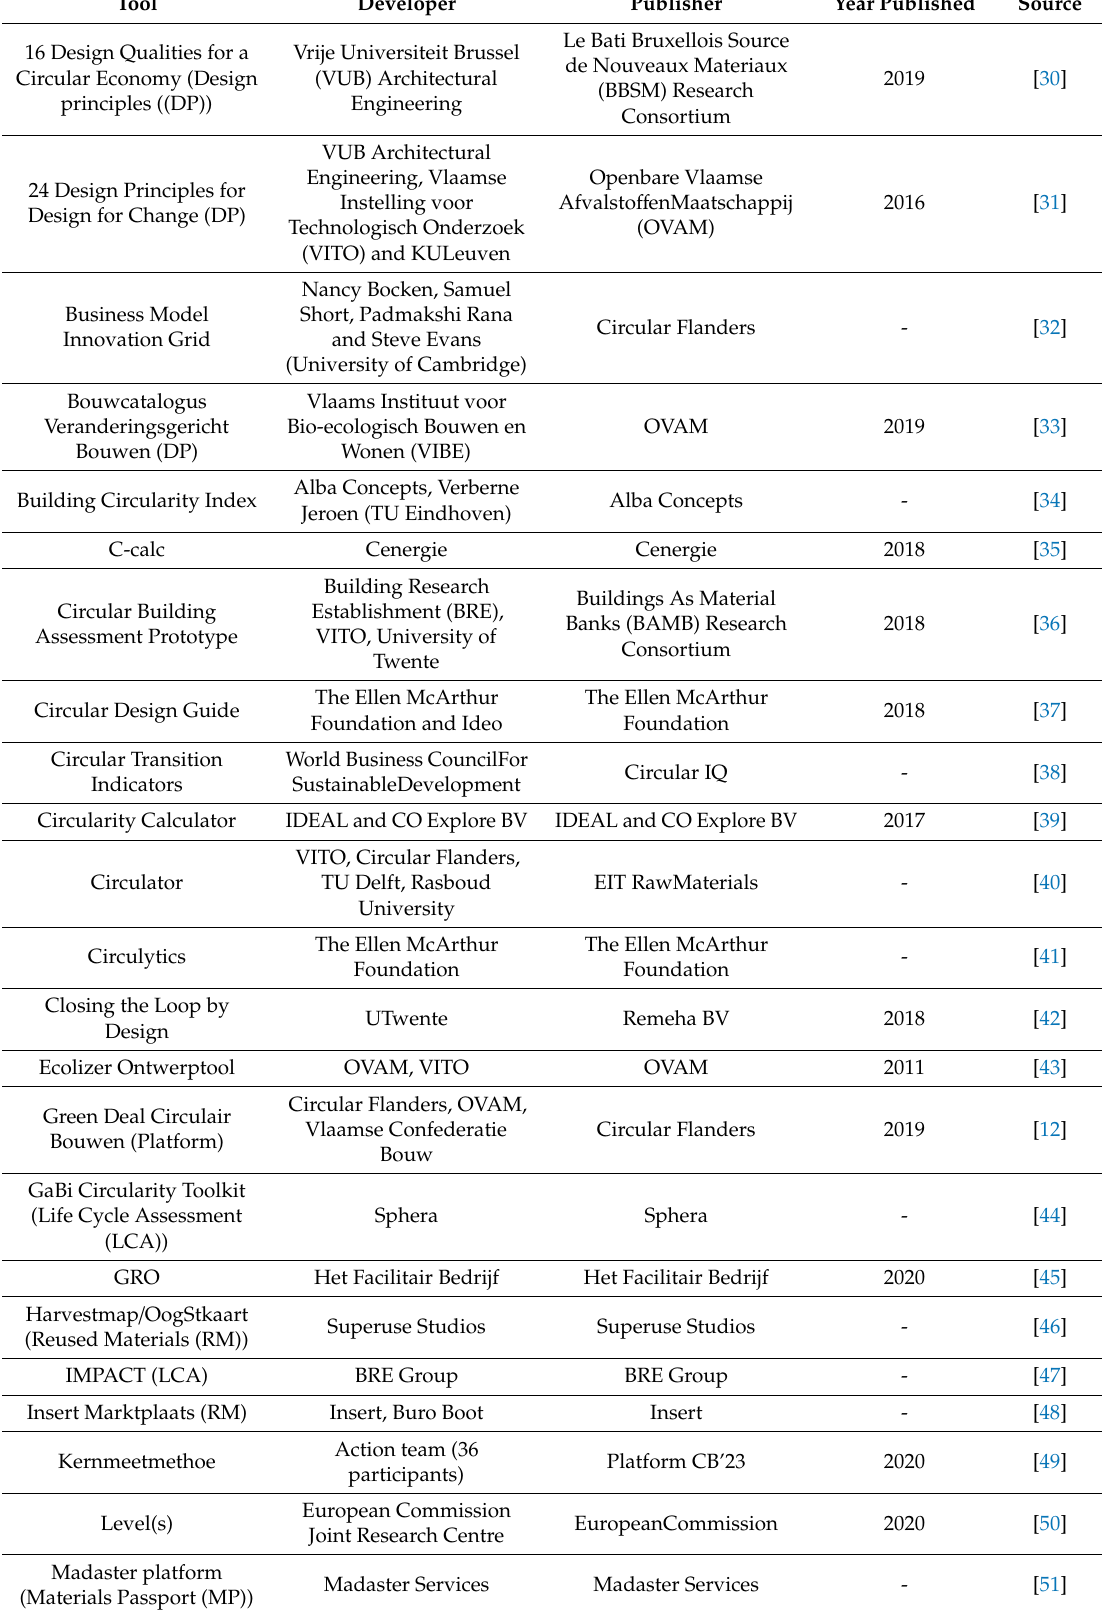
Table 1. Non-exhaustive list of design support tools for circular building in alphabetical